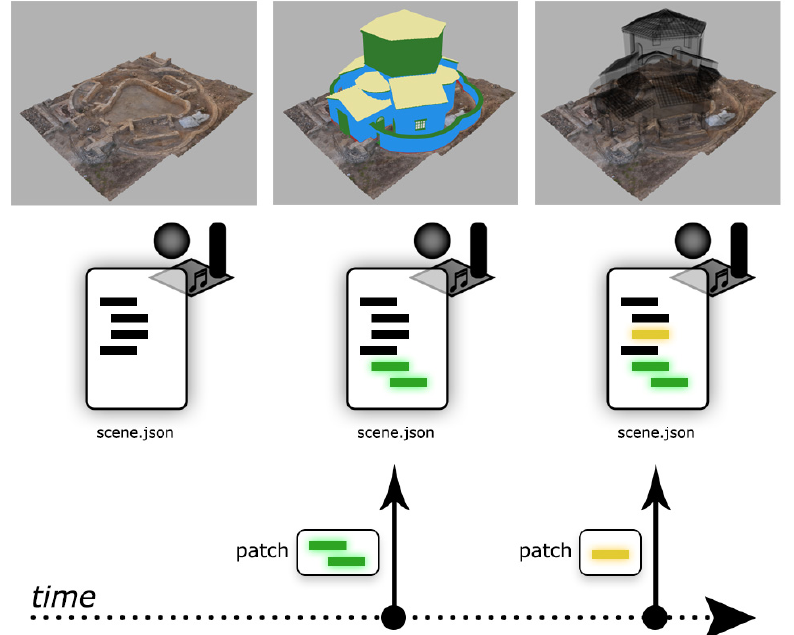
Figure 6. Sample JSON patches (add node, update material) sent over time to the server to apply partial modifications to the 3D scene